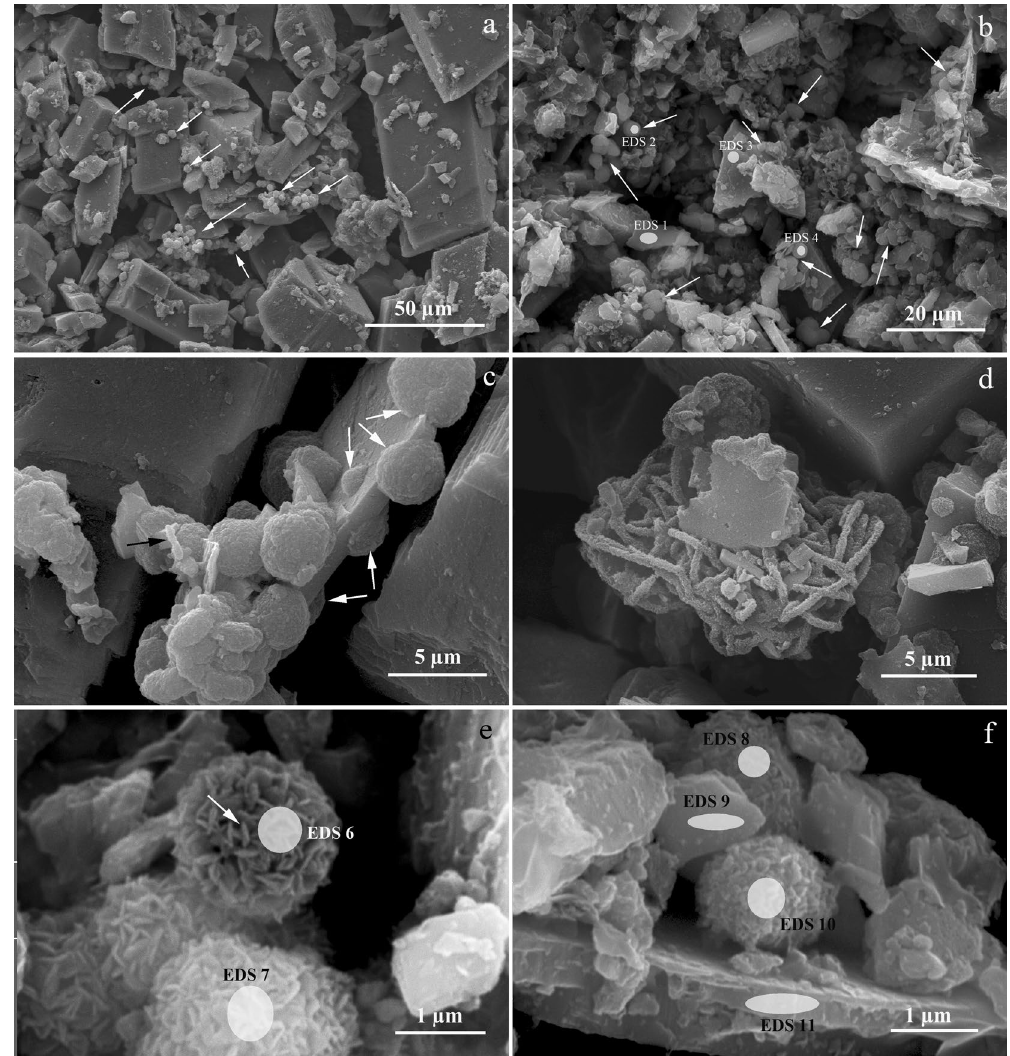
( b ) hydrothermal siderite and newly formed globules (white arrows); spots of EDS analysis (white ovals) (Supplementary Table S4); ( c ) metabolically induced siderite globules formed on the surface of hydrothermal siderite (white arrows) and bacterial cells (black arrow); ( d ) fossilized bacterial cells; ( e , f ) structure of globules consisting of small flat crystals. White ovals indicate spots of EDS analysis (Supplementary Table